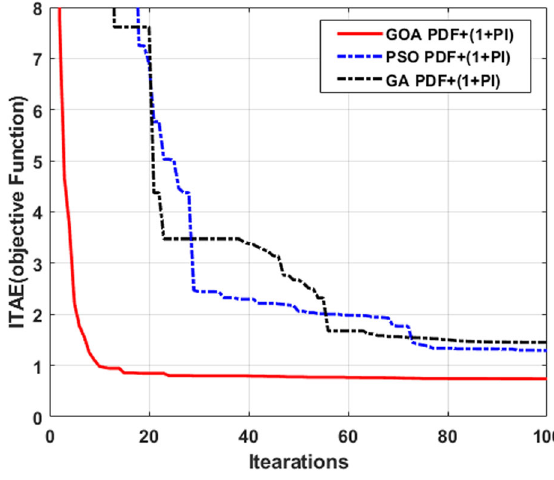
Fig. 6 Study of the objective function with PDF plus (1 + PI) Fig. 7 Convergence curves for GA, PSO &